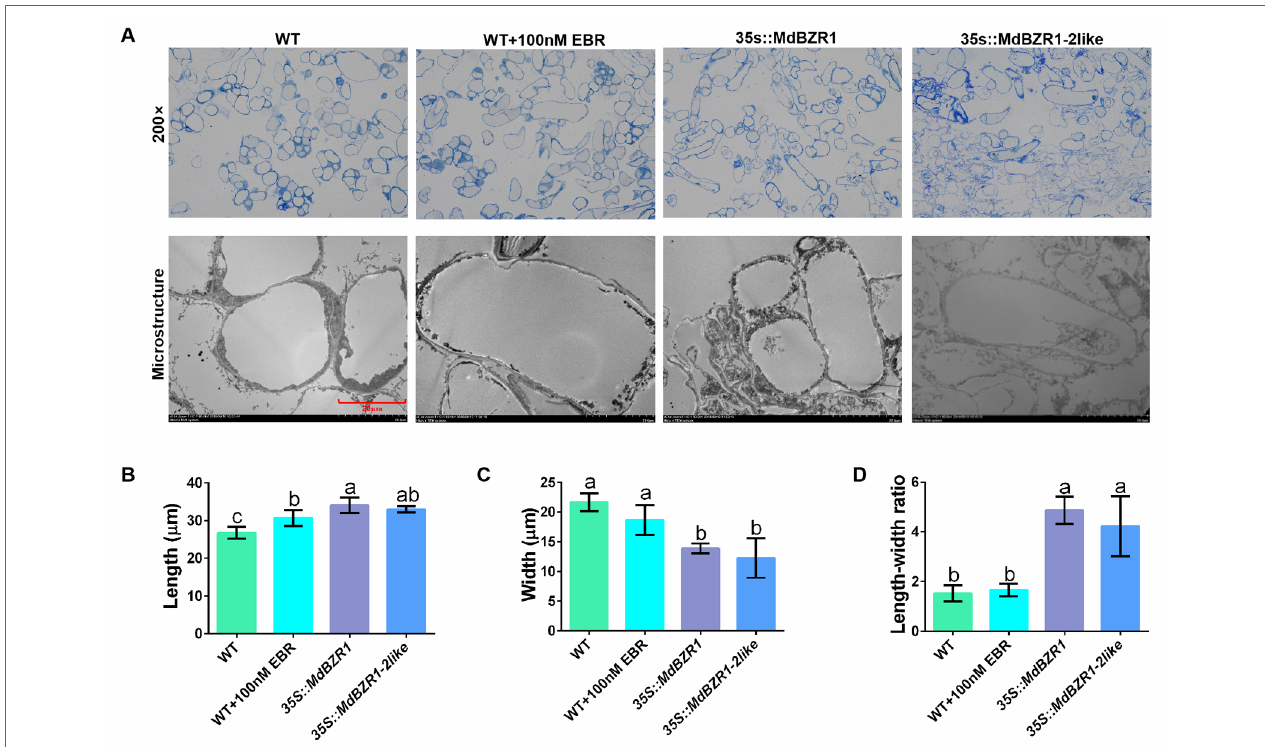
FIGURe 2 | Cell elongation in 35S::MdBZR1 and 35S::MdBZR1-2like calli (A) Microstructure of 35S::MdBZR1 and 35S::MdBZR1-2like apple calli. (B) Longitudinal analysis of apple calli cells. (C) Transverse analysis of apple calli cells. (D) The length/width ratio of apple calli cells. Data are shown as means ± SE of three replicates. Different letters indicate significant differences at p < 0.05.